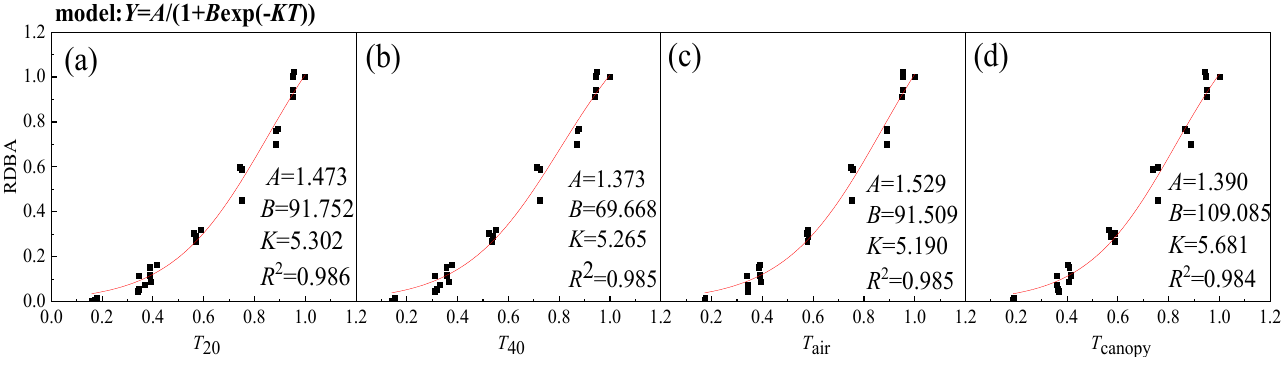
Figure 10. Simulations of RDBA based on the N-logistic model with four inputs from all plots in 2018: ( a ) T 20 ; ( b ) T 40 ; ( c ) T air ; ( d ) T canopy . Table 1. Calibration results and inter-annual differences of the N-logistic model parameters with T 20 , T 40 , T air , and T canopy in 2017–2019.